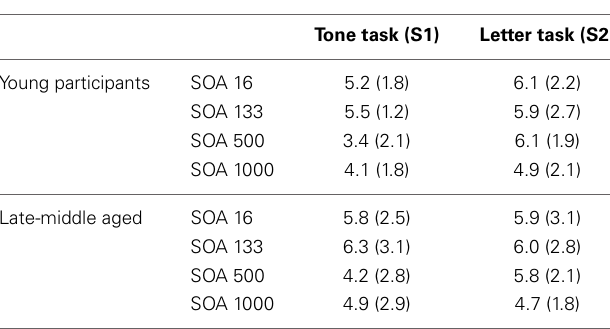
Table 1 | Mean and standard deviation of the error rates in the different SOA conditions separated for the different age